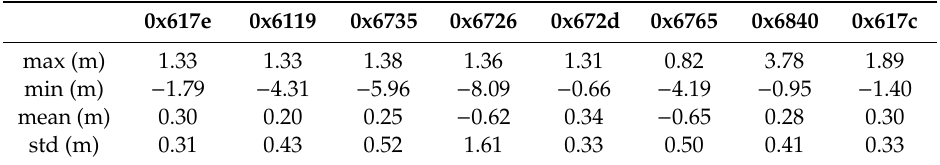
Table 3. Statistical parameter of the errors in ranging measurement for 8 anchors during all 5 tests performed.